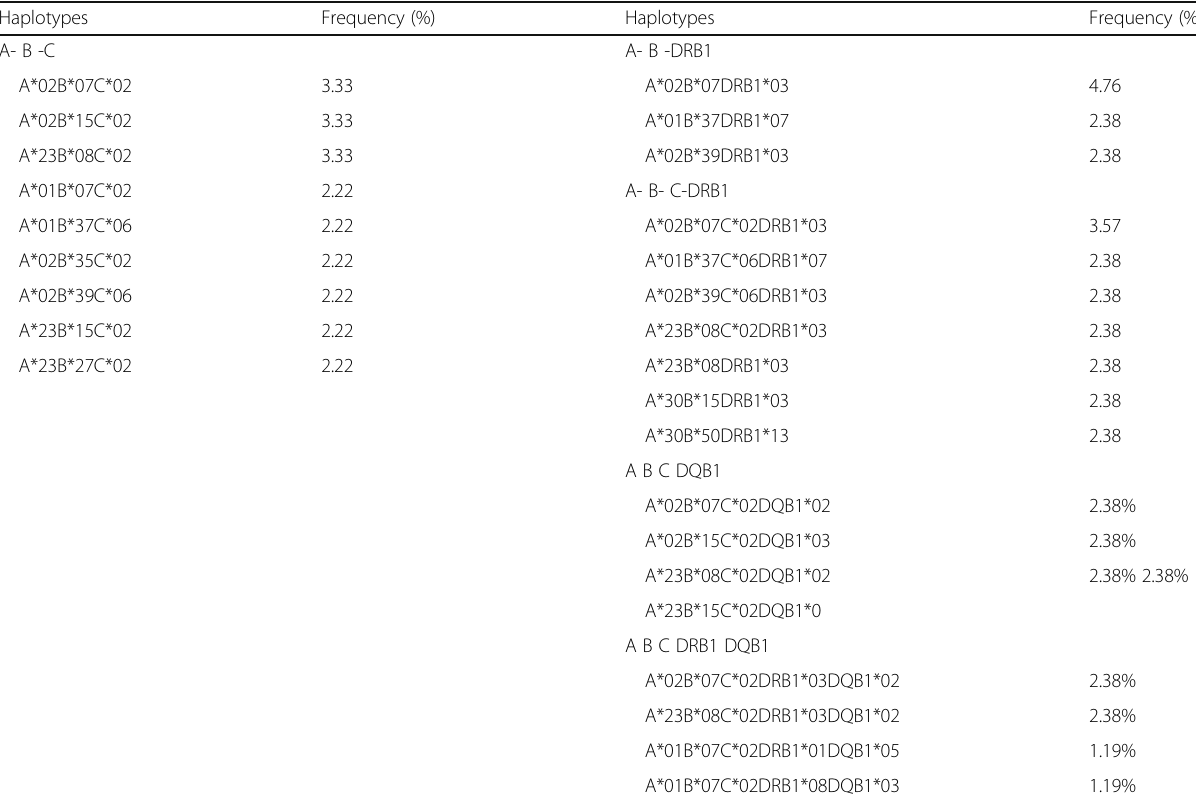
Table 5 Most encountered HLA (class I-class II) 3, 4 and 5 loci haplotypes